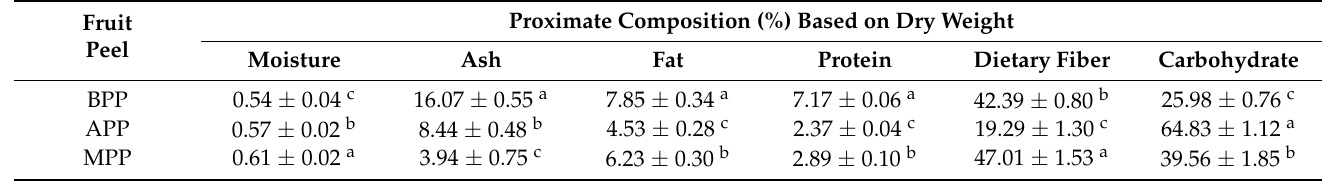
Table 1. Results of proximate composition in the three tested fruit peel powders reported as % in dry weight. Proximate Composition (%) Based on Dry Weight Fruit Peel Moisture Ash Fat Protein Dietary Fiber Carbohydrate